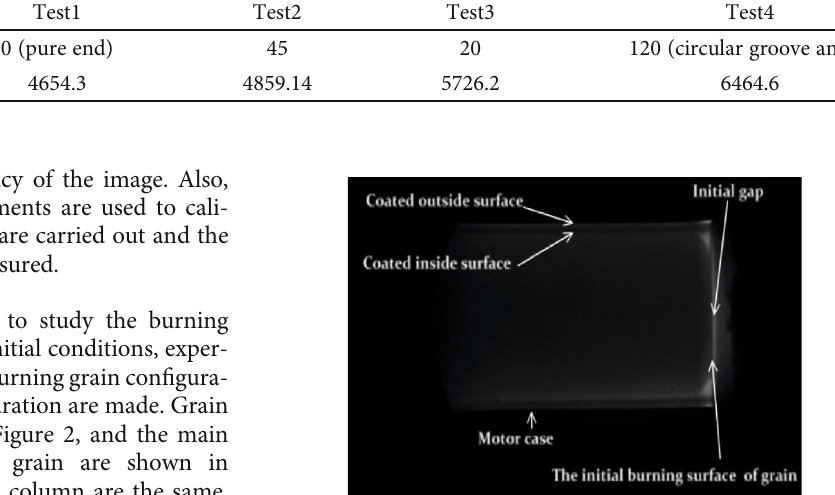
Figure 3: Static map of grain ’ s initial